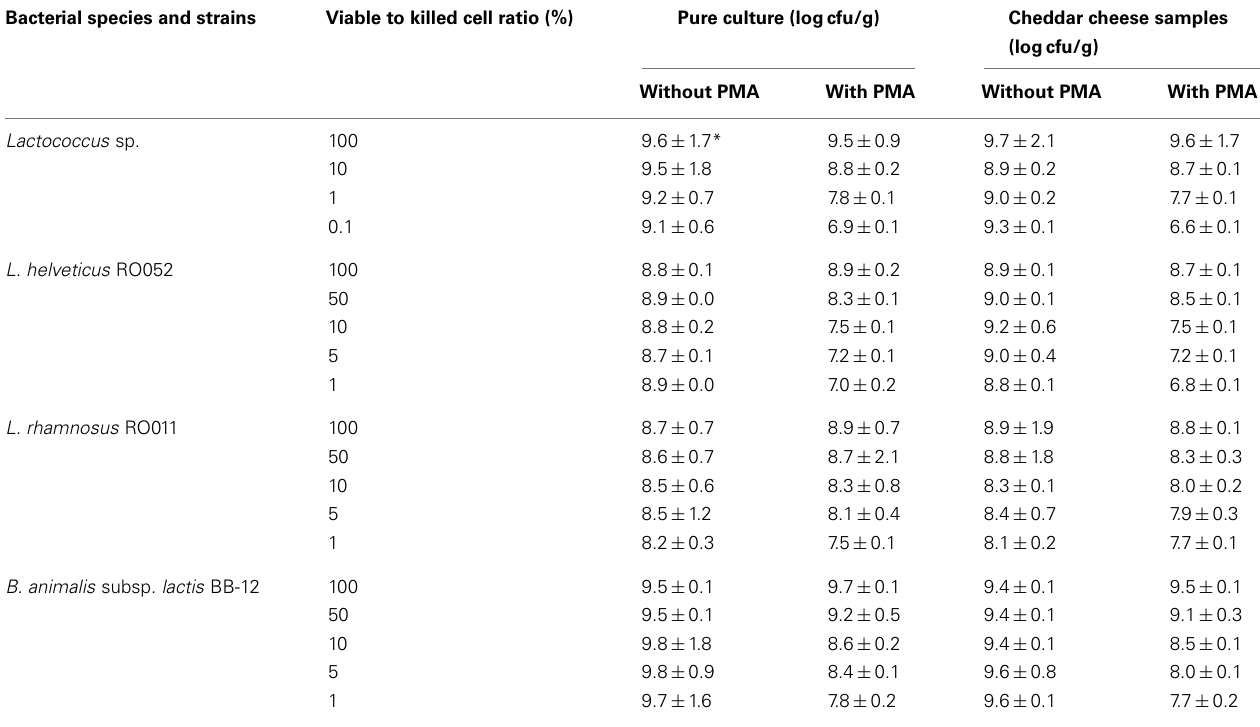
Table 4 | Effect of propidium monoazide (PMA) on PCR quantification of defined ratios of viable to killed cells in pure culture or in Cheddar cheese samples. Bacterial species and strains Viable to killed cell ratio (%) Pure culture (logcfu/g) Cheddar cheese samples